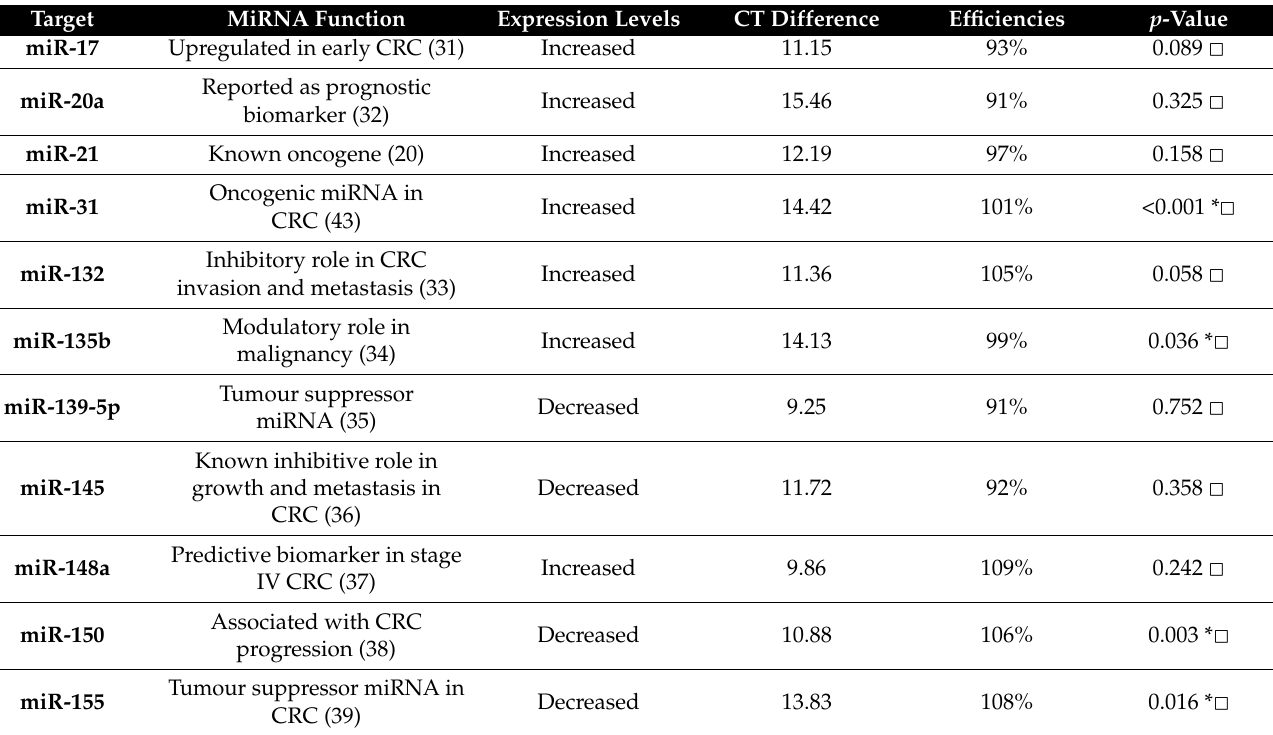
Table 2. The relevance of the use of discovery cohort of 15 target miRNA and 2 endogenous controls in differentiating tumour tissue from tumour-associated normal tissue in 27 colorectal cancer tissue and 27 ‘normal’